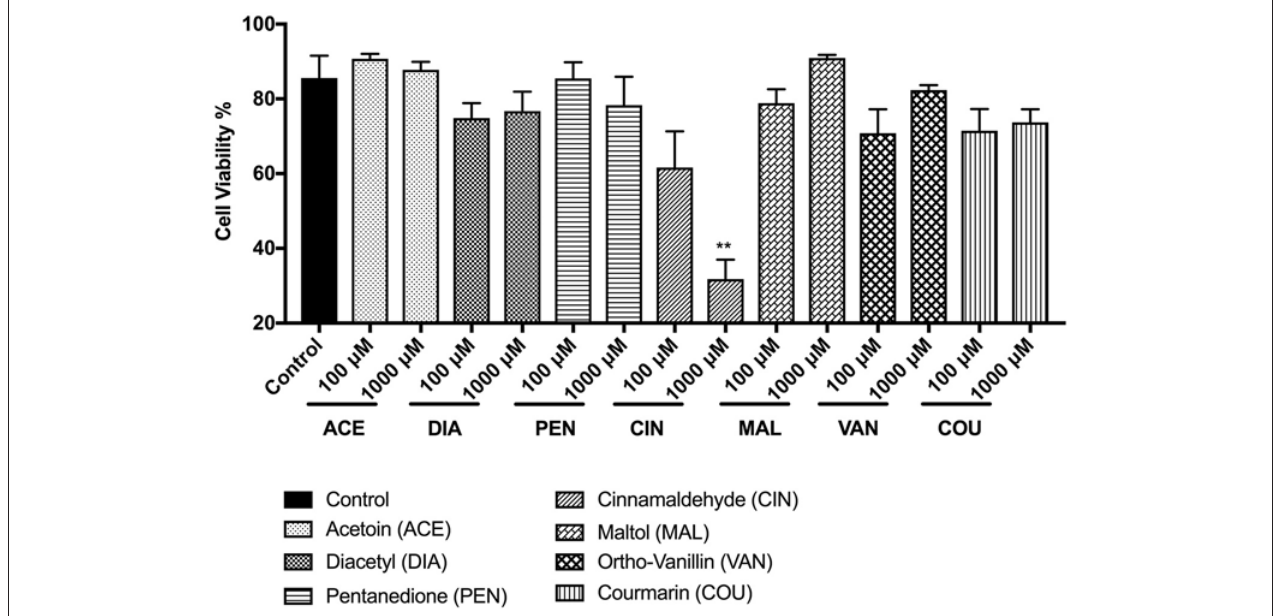
FIGURE 2 | Percent viability of Mono Mac 6 (MM6) cells 24h post-exposure to e-cigarette flavoring chemicals, i.e., acetoin, diacetyl, pentanedione, cinnamaldehyde, maltol, o-vanillin, and coumarin at concentrations 100 and 1,000 μ M. Mono Mac 6 cells were treated with e-cigarette flavoring chemicals and incubated at 37 ◦ C with 5% CO 2 for 24h. Cells were rinsed with PBS and stained with AO/PI dye. The viability of the cells was assessed using the Cellometer 2000. Data are expressed as mean ± SEM ( n = 3 per group). Statistical significance was determined by one-way ANOVA (Tukey’s multiple comparison test). ** p < 0.01 vs. Control.